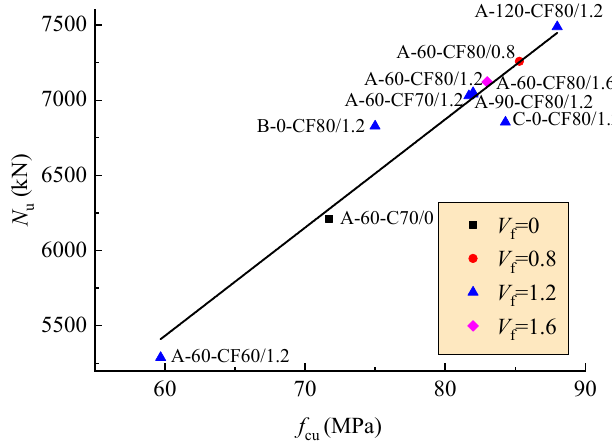
Figure 9. Changes of bearing capacity with concrete strength.